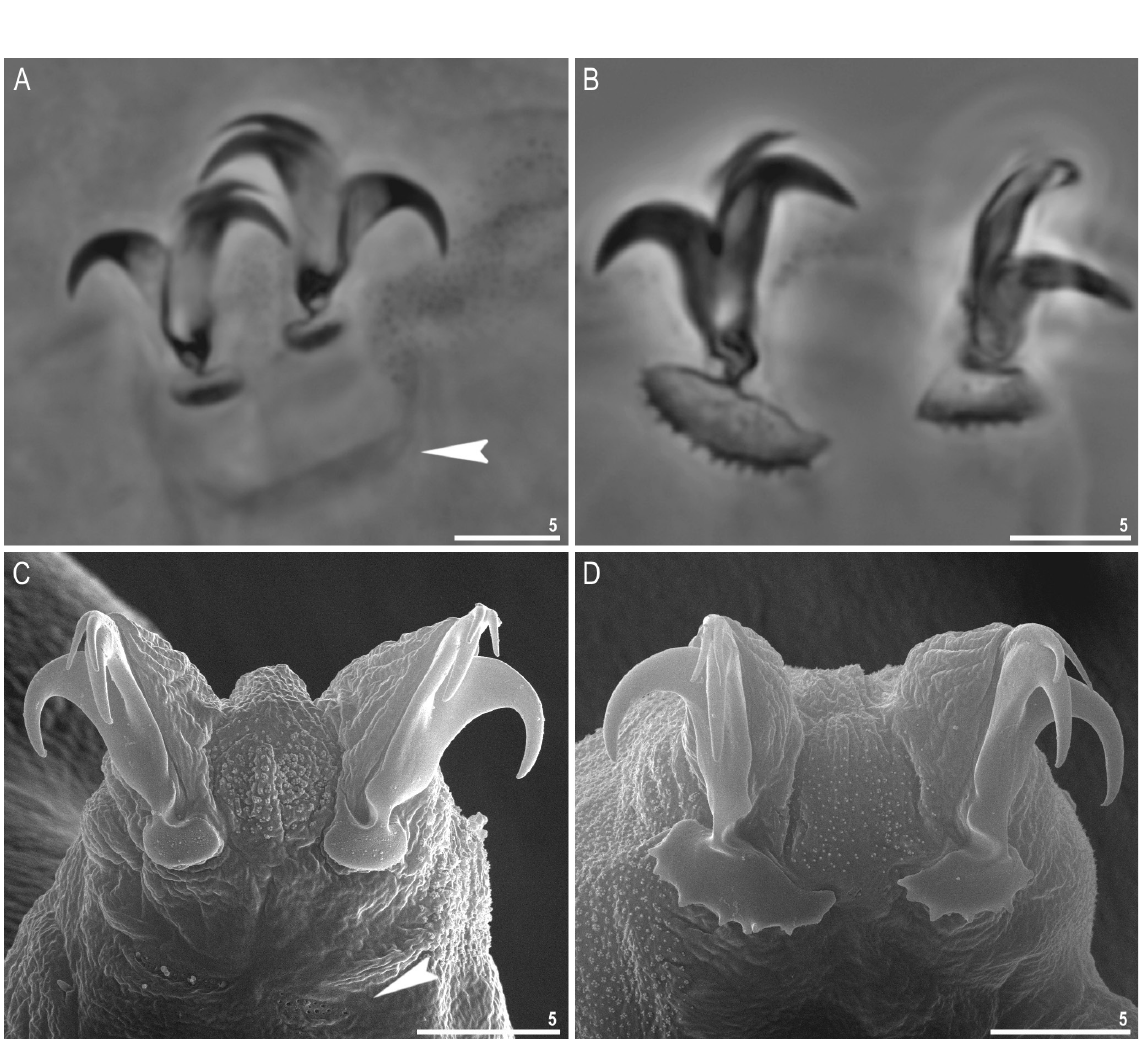
Fig. 3. Macrobiotus noongaris sp. nov., claws (paratypes, IZiBB). A–B . Claws II and IV seen in PCM, with smooth and dentate lunules, respectively. C–D . Claws I and IV seen in SEM, with smooth and dentate lunules, respectively. Filled indented arrowheads indicate double muscle attachments under the claws. Scale bars in μm.